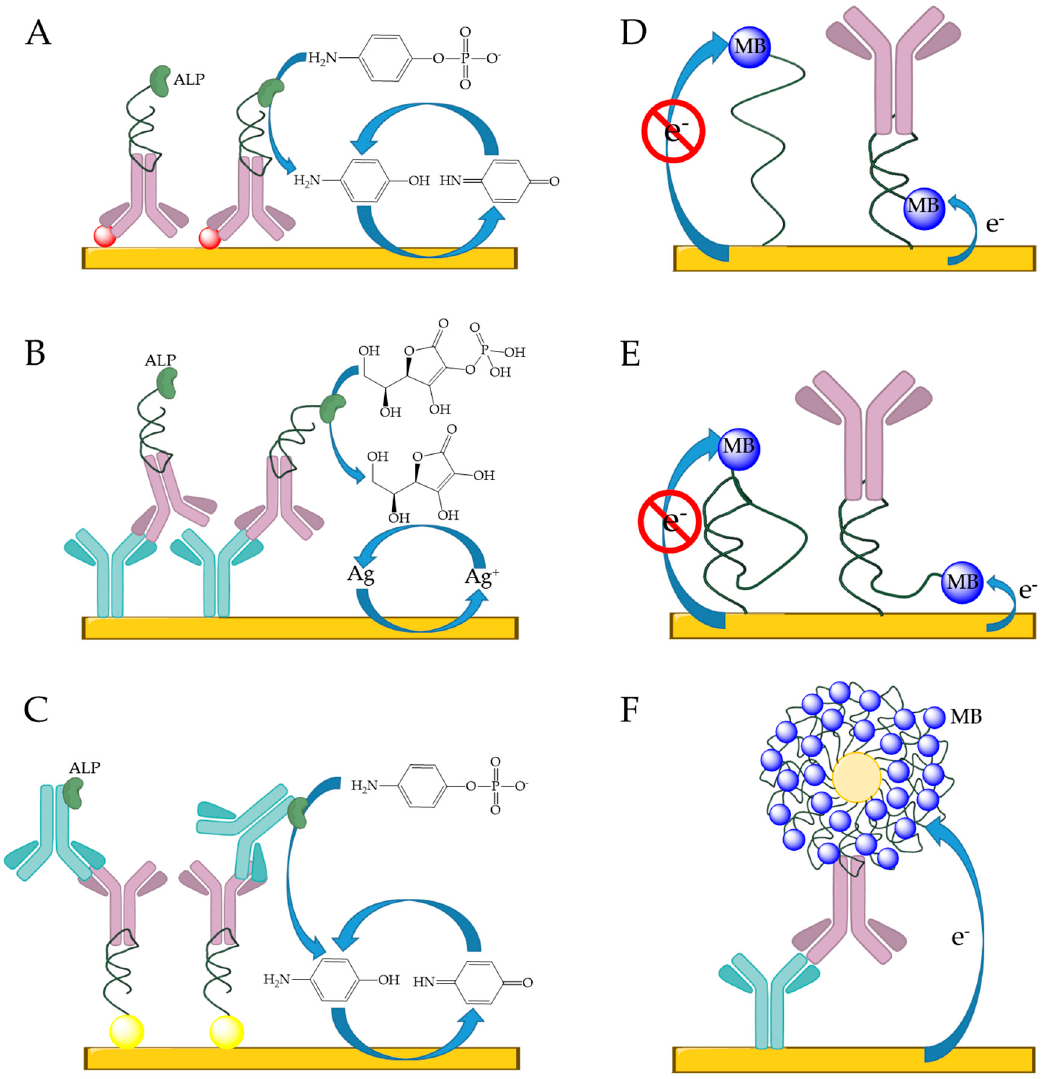
Figure 10. Voltammetric measurements, including: ALP activity in sandwich assays (( A) [151]; ( B) [152]; and ( C) [153]); conformational switching aptamers (( D) [157]; and ( E) [158]); and methylene blue accumulation in the G-rich domain of the aptamer (( F) [159]).